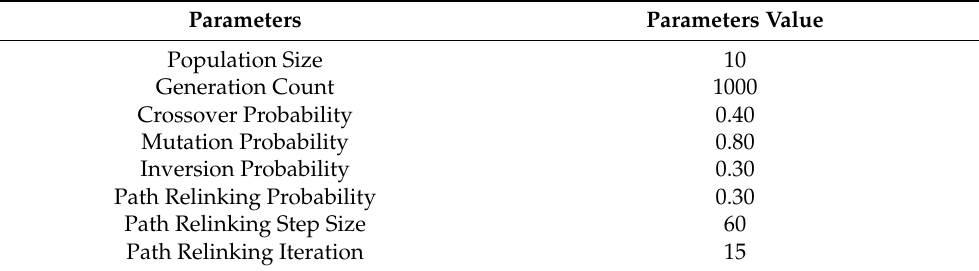
Table 3. GA parameter values of the experiment.